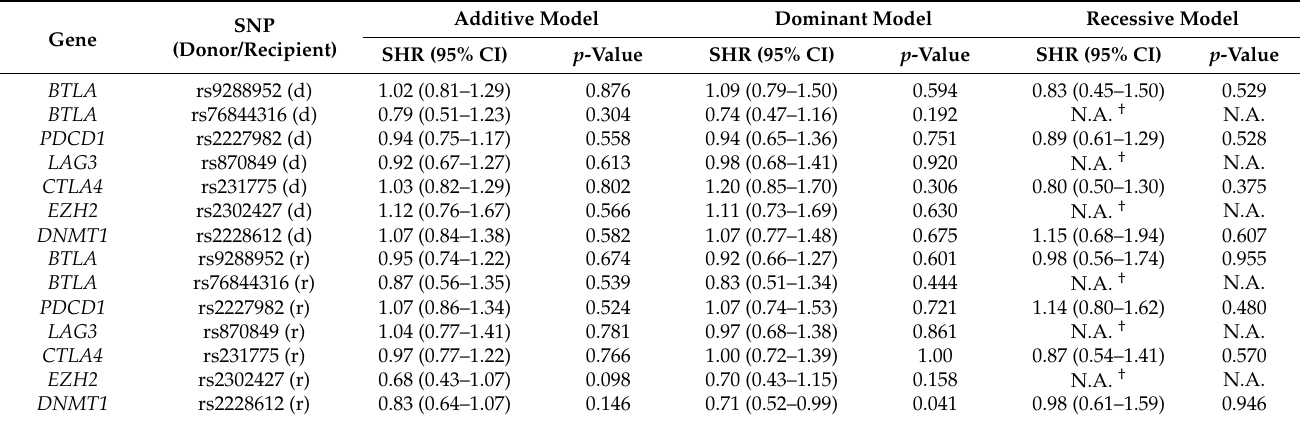
Table 7. Multivariable regression of relapse on donor and recipient